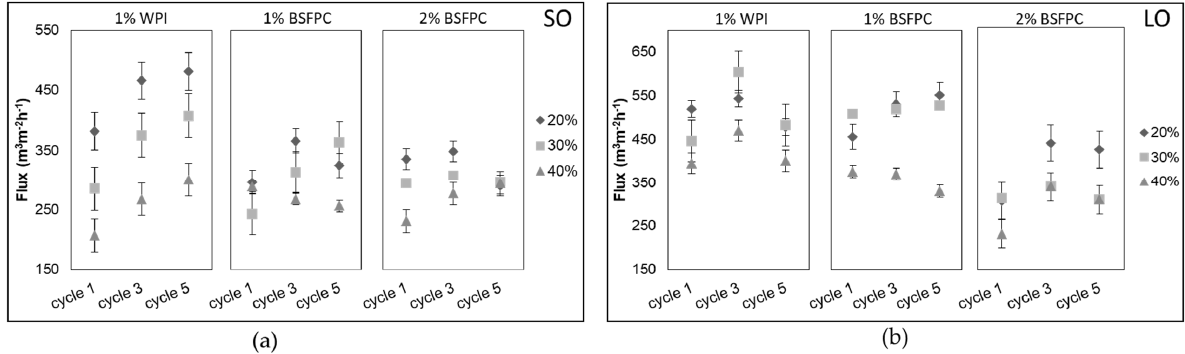
Figure 8. Transmembrane fluxes obtained at cycle 1, 3, and 5 during DMTS (dynamic membrane of tunable pore size) emulsifications of ( a ) SO (sunflower oil) emulsions and ( b ) LO (lemon oil) emulsions with different formulations.